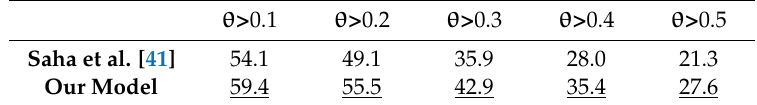
Table 8. Comparison of action-detection performances between different models; LIRIS-HARL dataset. θ > 0.1 θ > 0.2 θ >